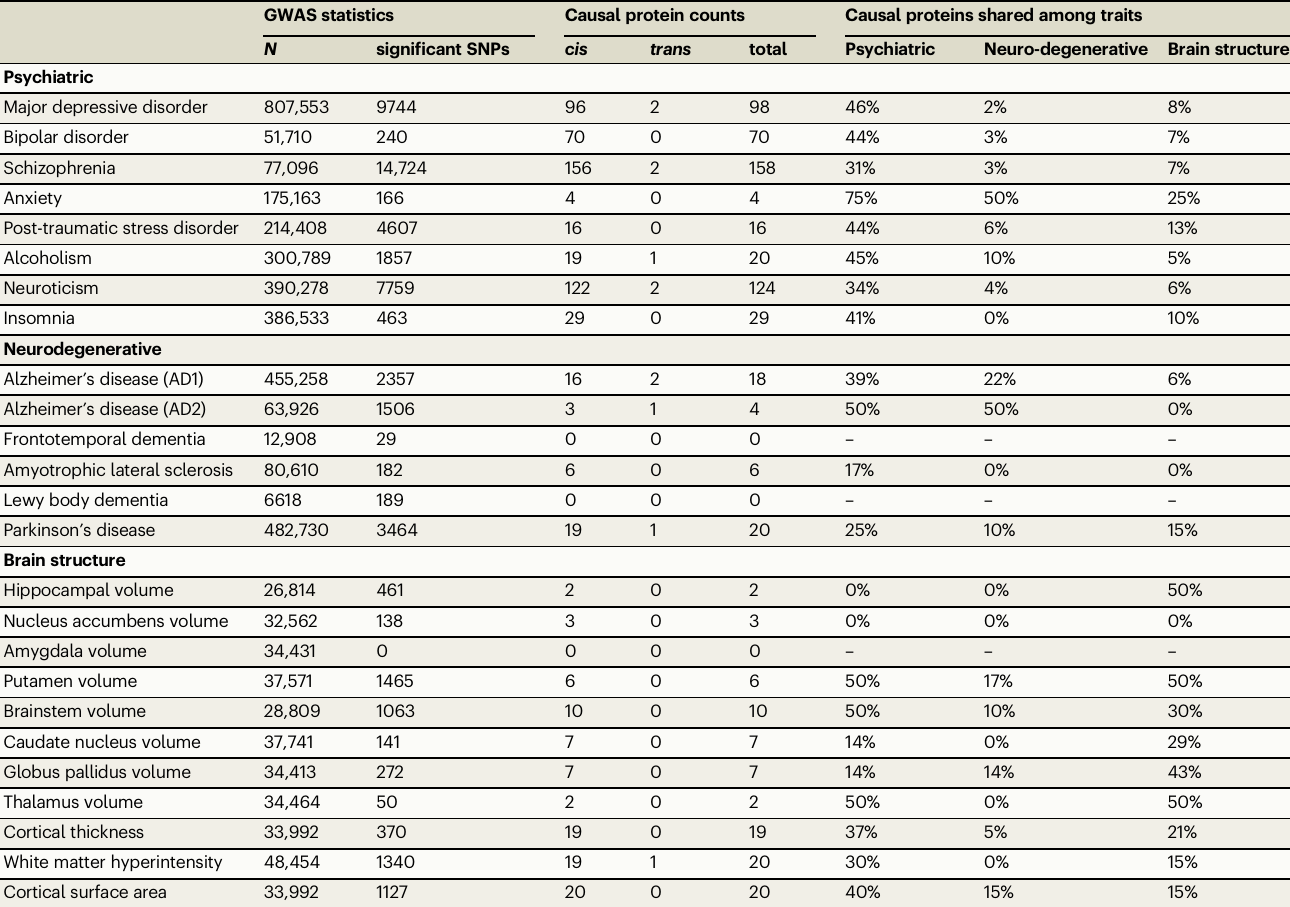
Table 1 | Summary ofthe source GWAS and number of causal proteins for each brain trait identi fi ed through PWAS, SMR/HEIDI, and